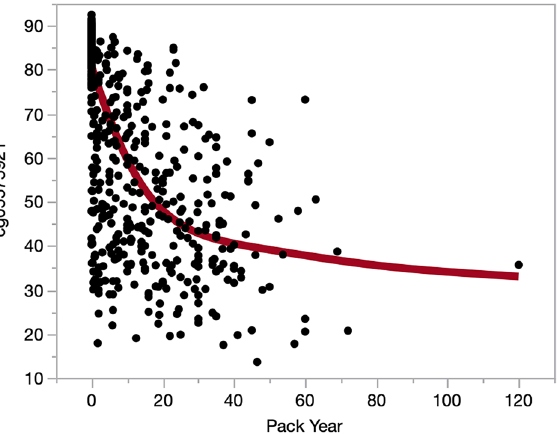
Figure 3. The relationship of WB cg05575921 methylation to lifetime cigarette consumption expressed as pack years. The line in red represent a smoothing spline fit with a lambda of 100,000 ( p < 0.0001, R 2 =